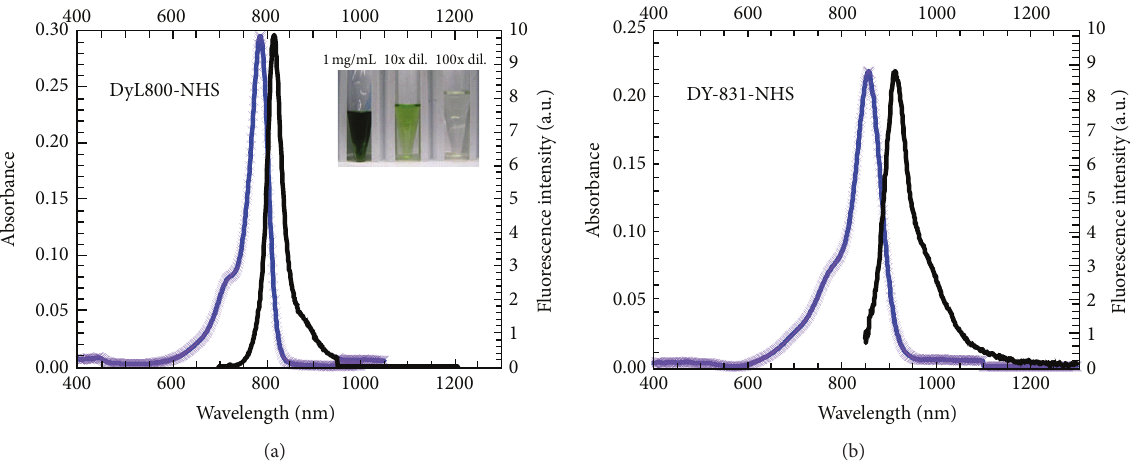
Figure 4: Normalized absorption and emission spectra of the NHS-functionalized form of DyL800 dye (a) and DY-831 dye (b) in DMSO solvent. At high concentrations, these dyes appear dark green or black to the eye. At concentrations resulting in peak attenuation of 90% in the infrared, they are transparent in the